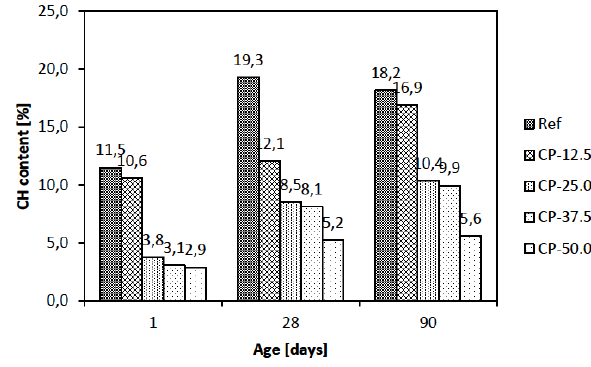
Figure 5: Development of hydrate water in pastes with fly ash addi- tion in time.